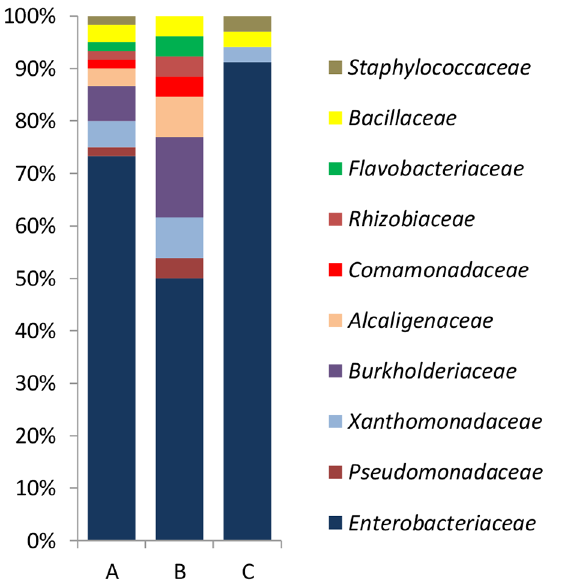
Figure 1. Microbial community composition, diversity and relative abundance of: total of bacteria carried by PWN (A), bacteria carried by PWN from P.sylvestris (B) and from P.nigra (C). The families: Alcaligenaceae , Bacillaceae , Burkholderiaceae , Coma-